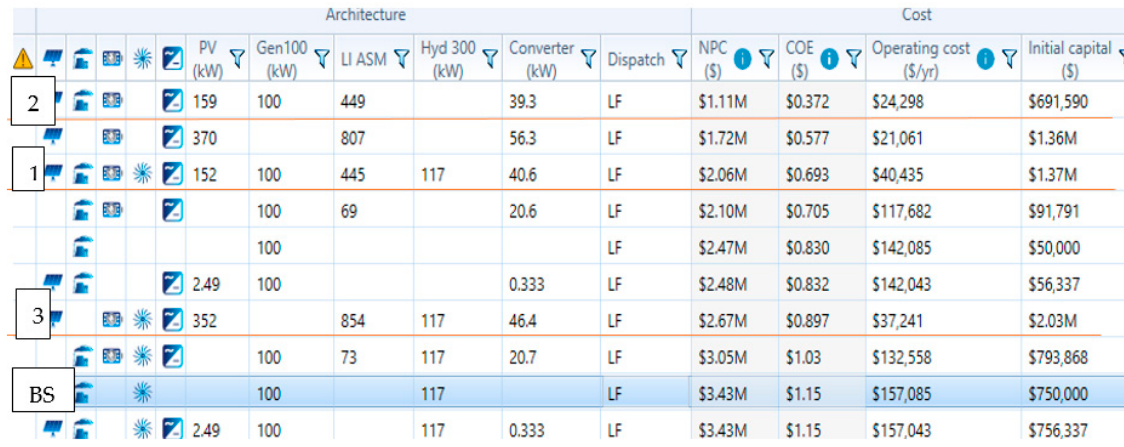
Figure 15. The result table showing the architectural design and cost comparison of simulated system, highlighting the base system (BS) and design options 1, 2, and 3.